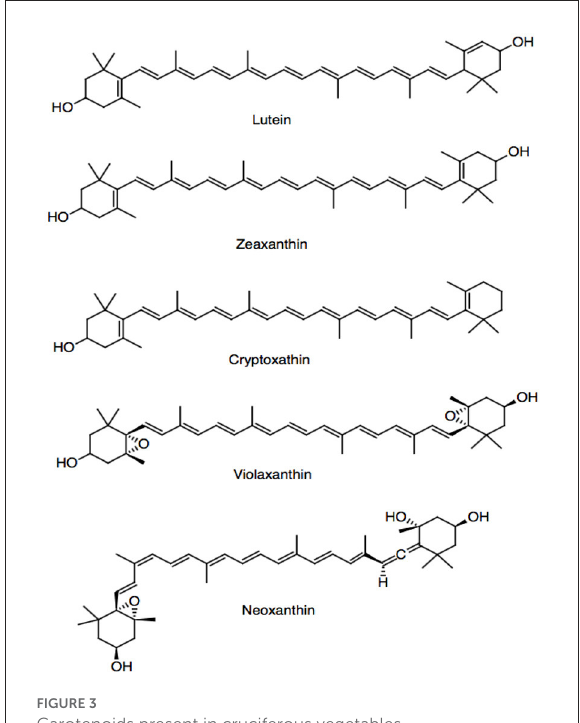
FIGURE3 Carotenoids present in cruciferous